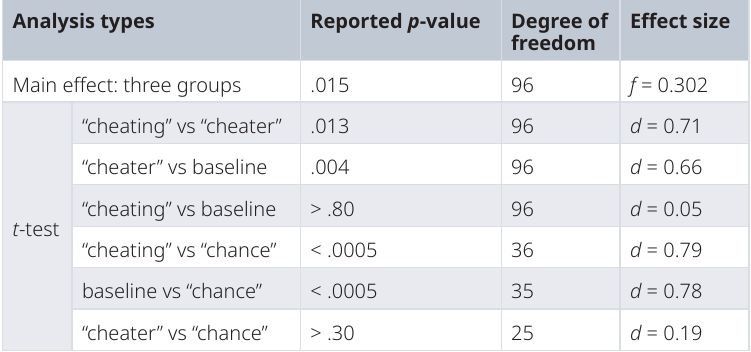
Table 1. Results of Experiment 3 of Bryan et al.